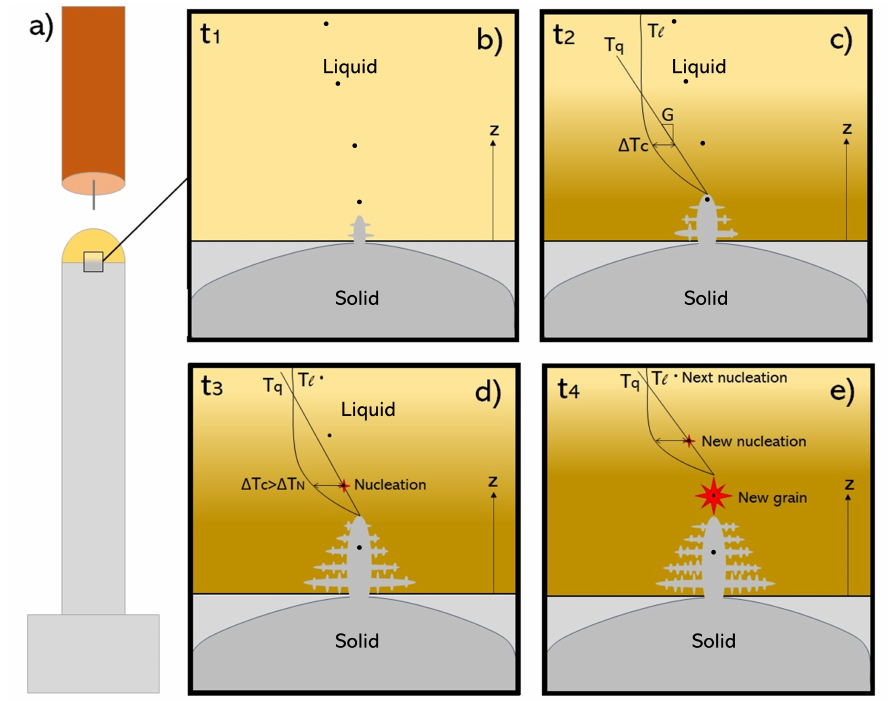
Figure 4. Schematic of epitaxial growth, development of a constitutional undercooled zone and heterogeneous nucleation during solidification of an alloy deposited by WAAM. ( a ) Illustration of a WAAM structure. Last layer is still in liquid phase (marked yellow). ( b ) Newly formed dendrite in the melt, epitaxially grown on the former layer. ( c ) Formation of a constitutional undercooled zone ∆ T c due to solute redistribution. Undercooling is insufficient for heterogeneous nucleation. ( d ) Heterogeneous nucleation of a new grain on a second-phase particle. ( e ) Growth of new grain and a new nucleation event. Reproduced with permission from Bermingham et al., Acta Materialia; published by Elsevier, 2019